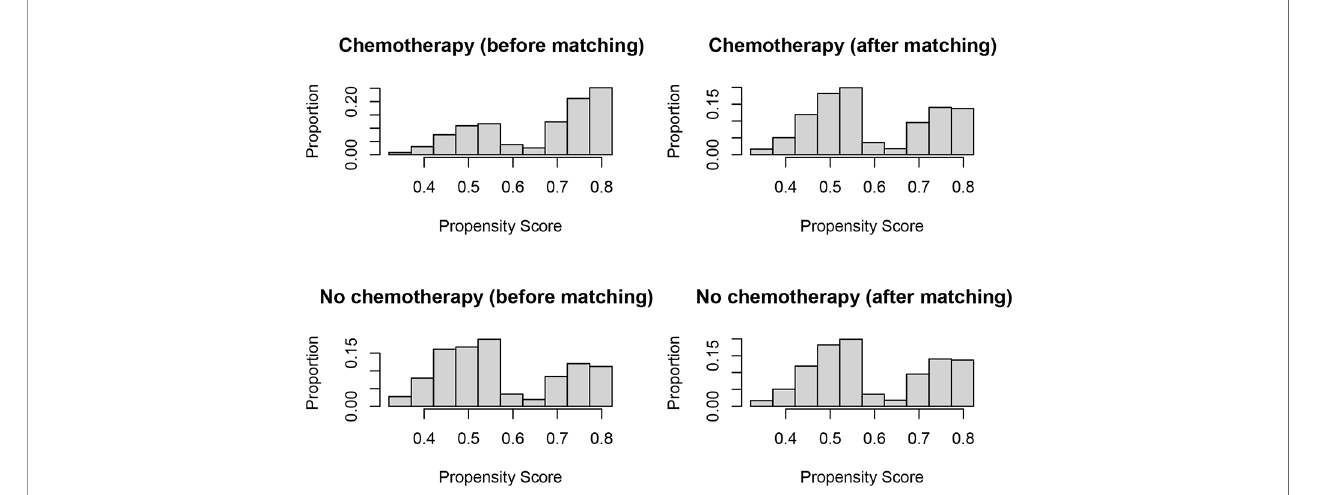
FIGURE 2 | Distribution histograms before and after propensity score matching (treated = no surgery; control = radical surgery).